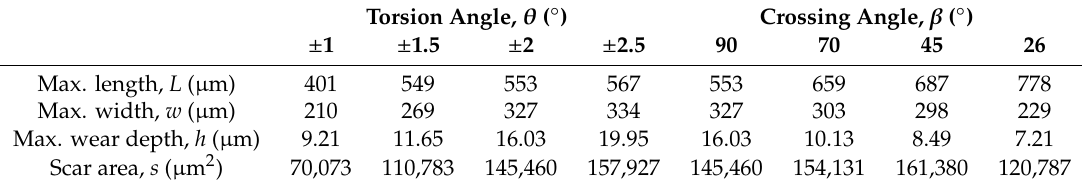
Table 8. Dimensions of wear scars of cyclic loaded wires at different torsion angles and crossing angles.